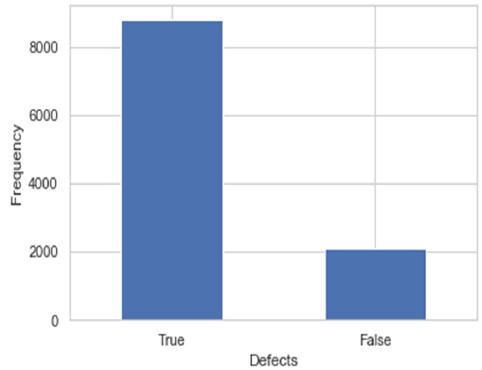
Figure 1. Transaction class against the frequency.